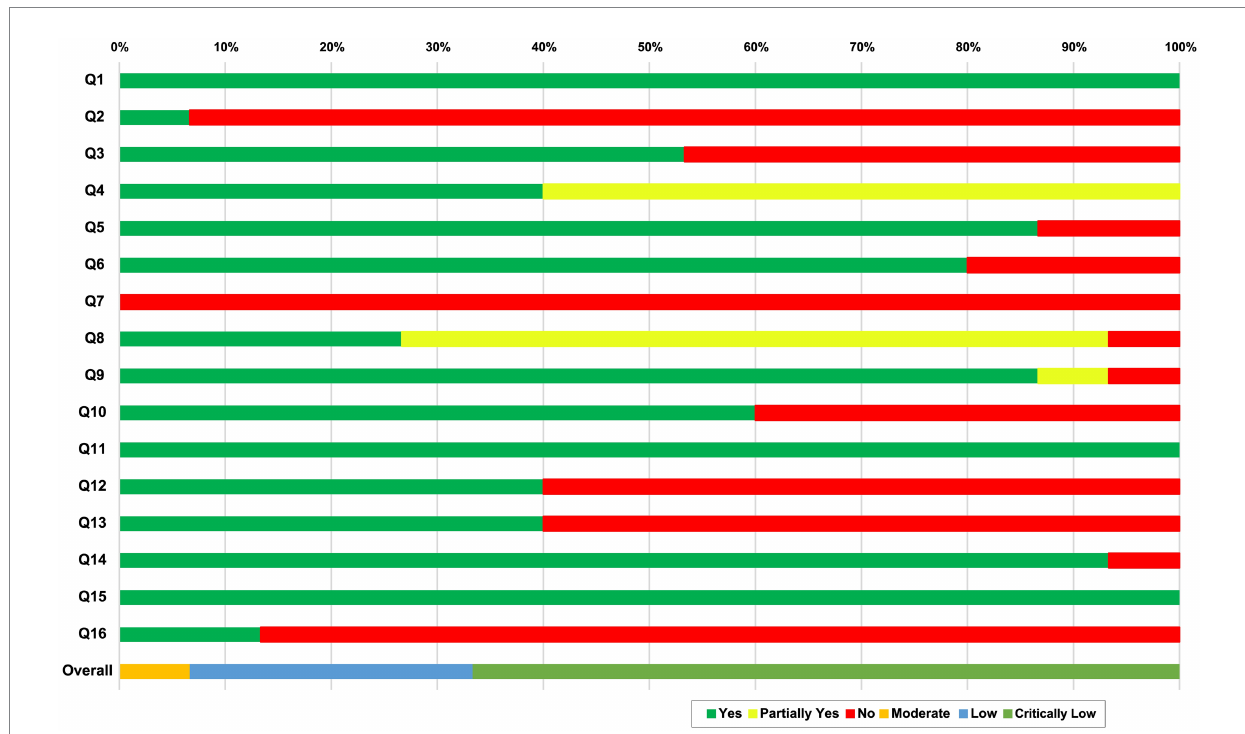
FIGURE 2 Quality evaluation using AMSTAR 2. AMSTAR2 was used to critically appraise the reporting quality of each included SR. The overall confidence of each SR was graded as “high” (no or non-critical weakness in all items), “moderate” (more than one non-critical